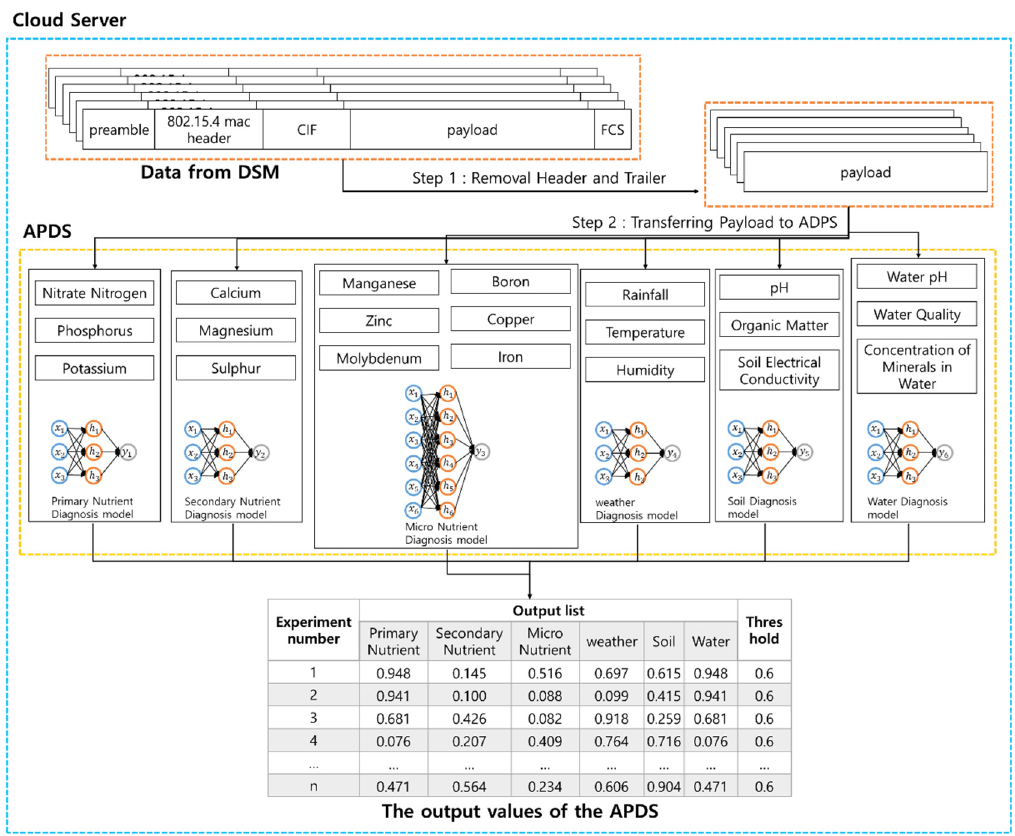
Figure 8. The structure of the agricultural partial diagnosis sub-module (APDS).